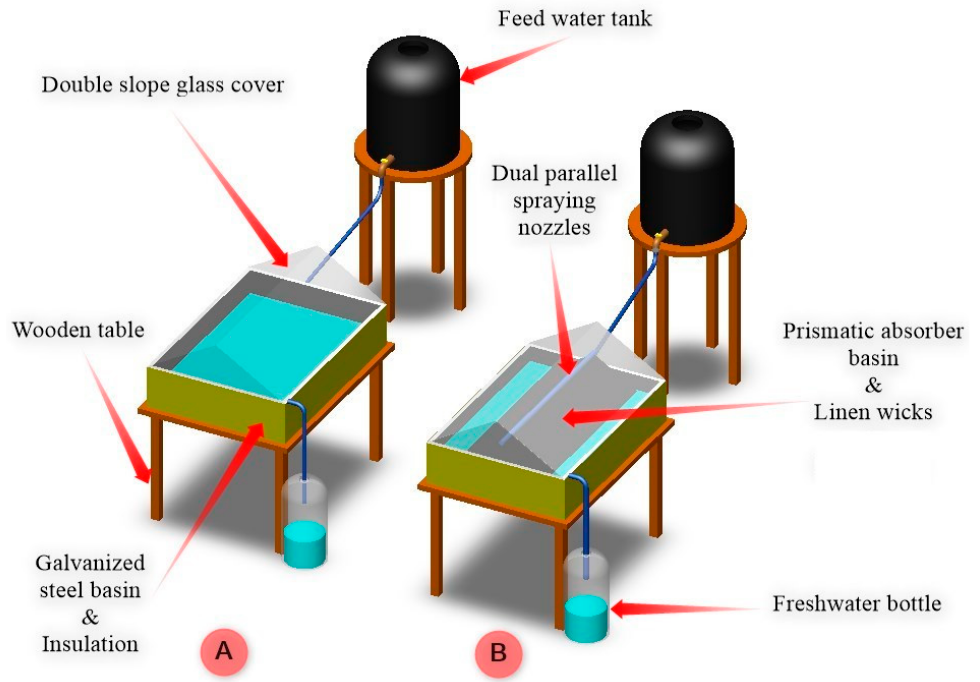
Figure 1. The layout of experimental test-rig of TDSSD ( A ) and DSSD-WPB&DPSN ( B ).